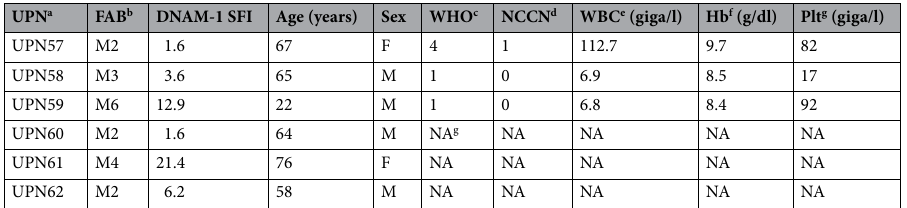
Table 1. Clinical characteristics of the patient cohort. a UPN: unique patient number. b FAB: French– American–British classification. c WHO: WHO Classification 2008. 1—AML with recurrent genetic aberrations; 2—AML with myelodysplasia-related changes; 3—Therapy-related myeloid neoplasms; 4 AML, not otherwise specified. d NCCN: National Comprehensive Cancer Network classification 2018. 0—favorable risk, 1—intermediate risk, 2—poor risk, 3—not defined. e WBC: white blood cell count. f Plt: thrombocytes. g NA: no data